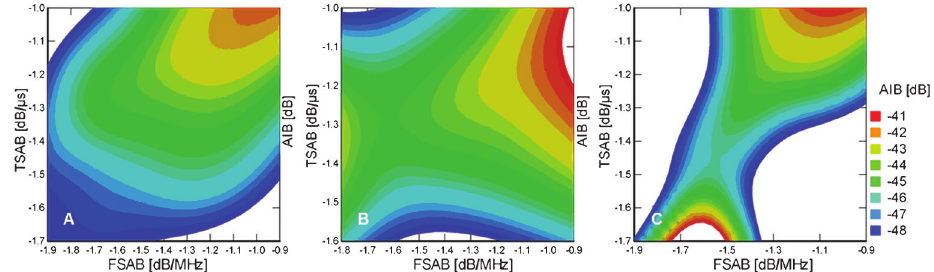
Figure 5. Correlation between the backscatter parameters (AIB, FSAB, and TSAB) in Experiments 1-3 of the bone. AIB: apparent integrated backscatter; FSAB: frequency slope of apparent backscatter; TSAB: time slope of apparent backscatter.